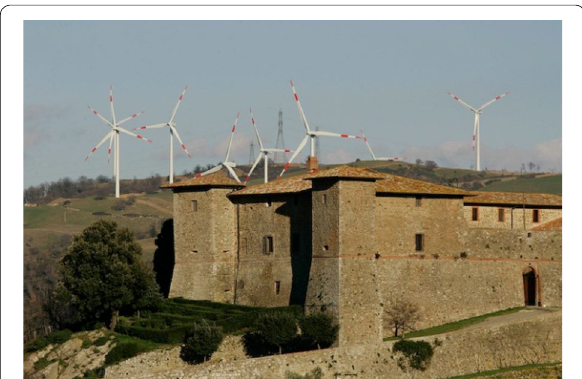
Fig. 2 Wind power plant in Poggi Alti, Scansano (GR) (Source: reteresistenzacrinali)